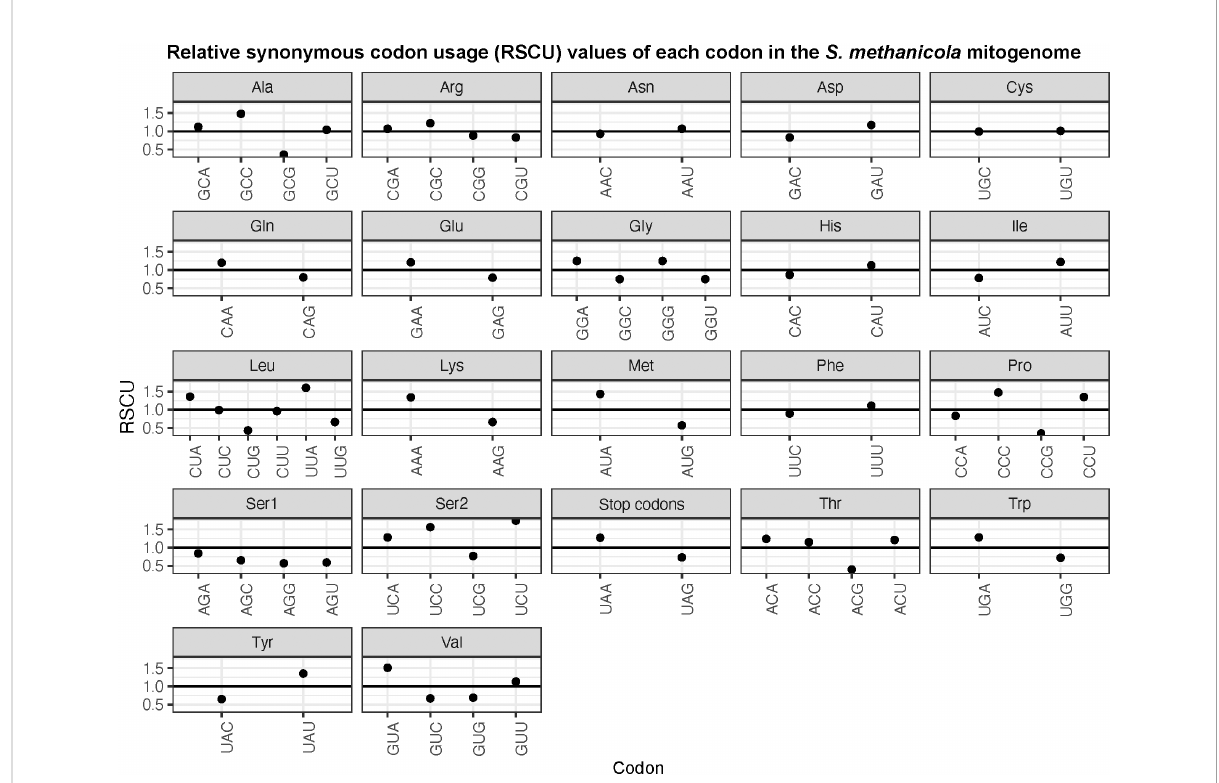
FIGURE 3 Relative synonymous codon usage (RSCU) values for each codon of each amino acid in the S. methanicola mitogenome. The black horizontal line on each plot marks the RSCU threshold of